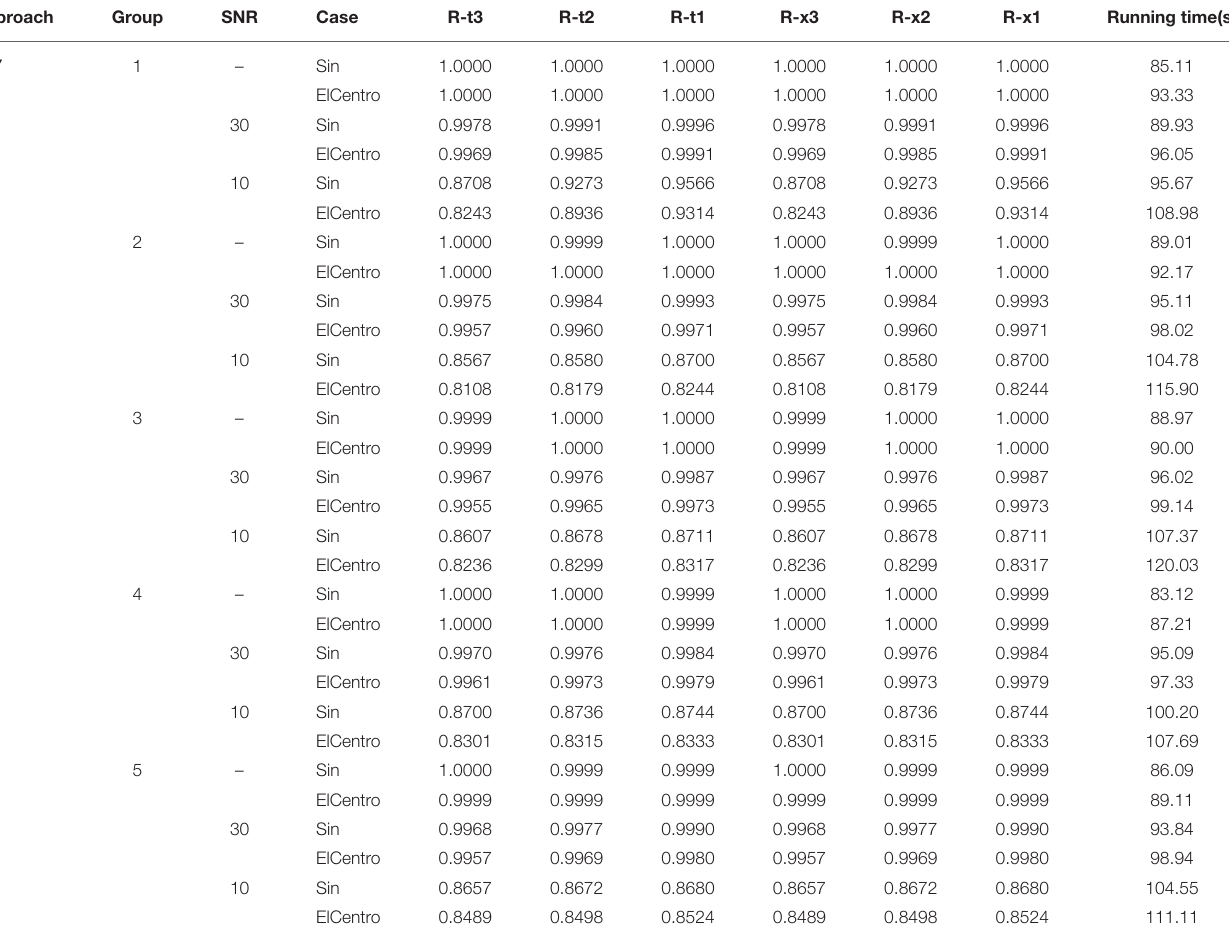
TABLE 5 | Correlation coefficient analysis (IPV).